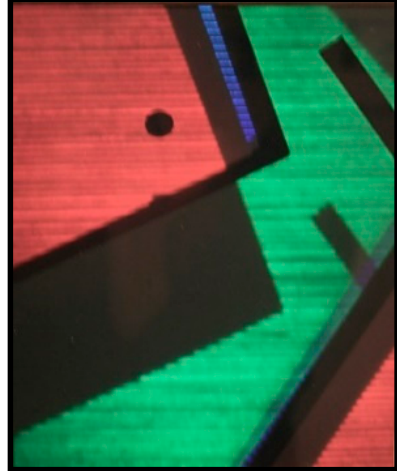
Figure 2. A simulation of how a different lamp can drastically alter the playback colours.